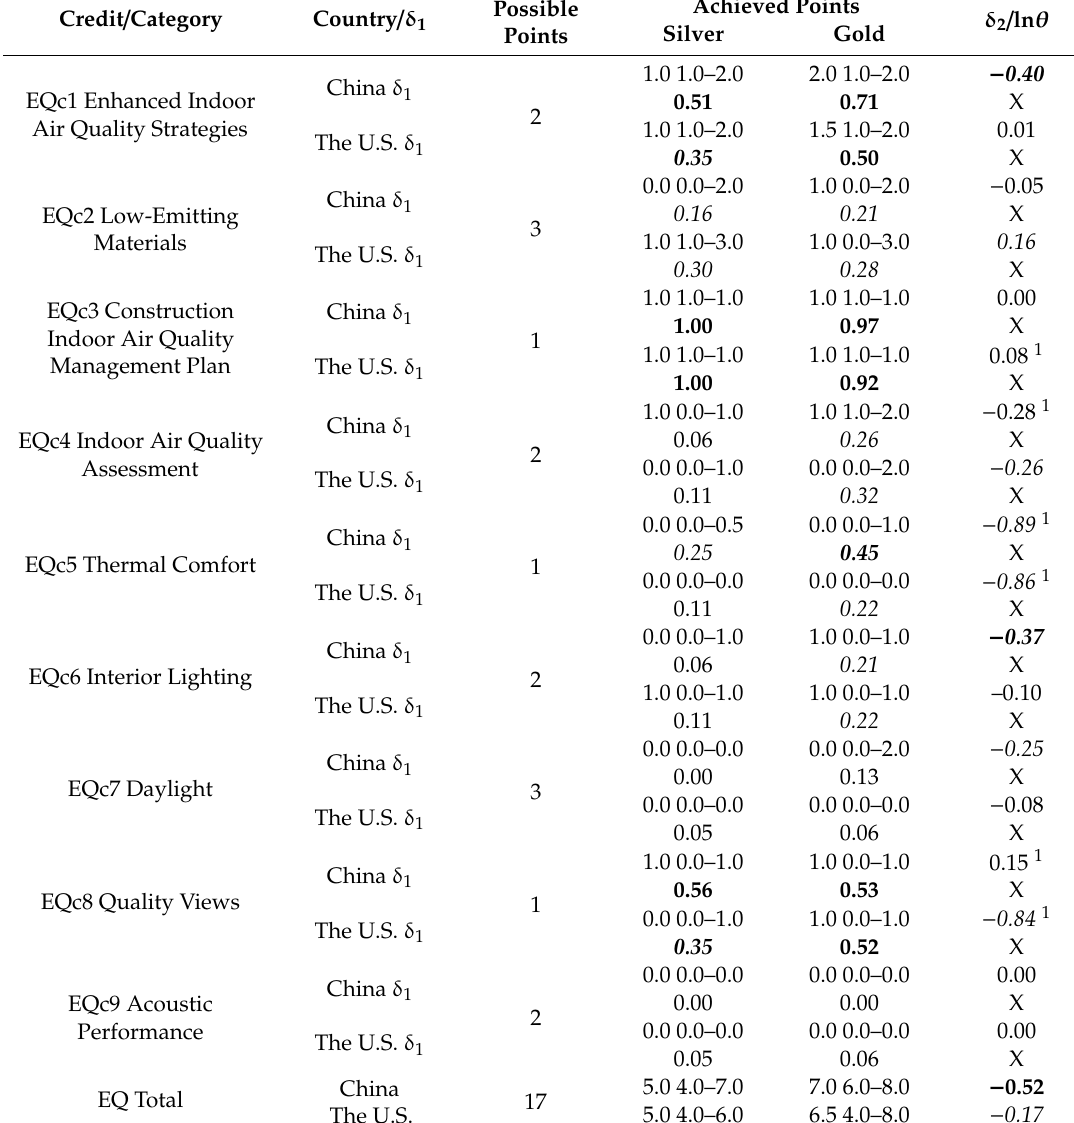
Table 10. LEED-CIv4 Indoor Environmental Quality (QE) credits category: The median and 25th–75th centiles and Cli ff ’s e ff ect size ( δ 1 ) of the di ff erence between the achieved and the possible points, and ( δ 2 ) or ln θ of the di ff erence between Silver and Gold projects in China and the